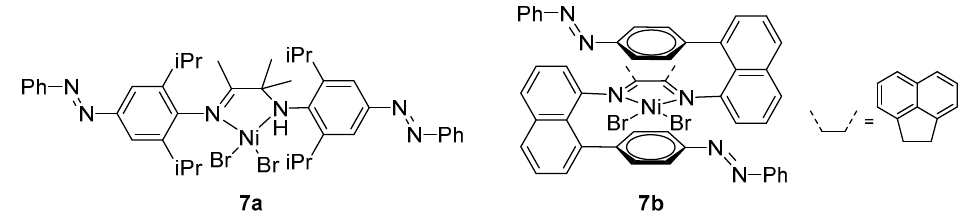
Figure 5. The azobenzene-functionalized nickel catalysts 7a , b .